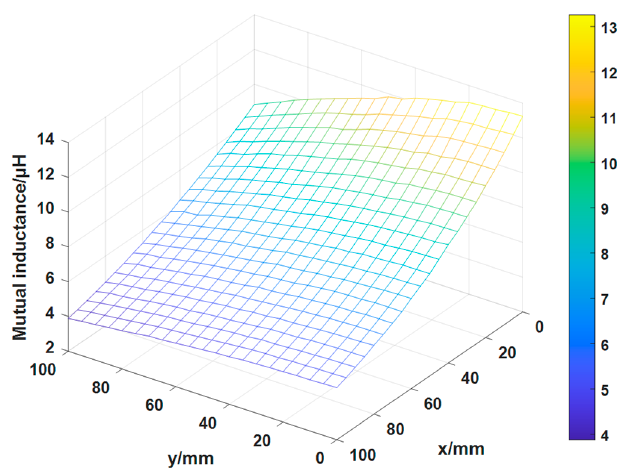
Figure 9. Measured mutual inductance with different x and y distances.